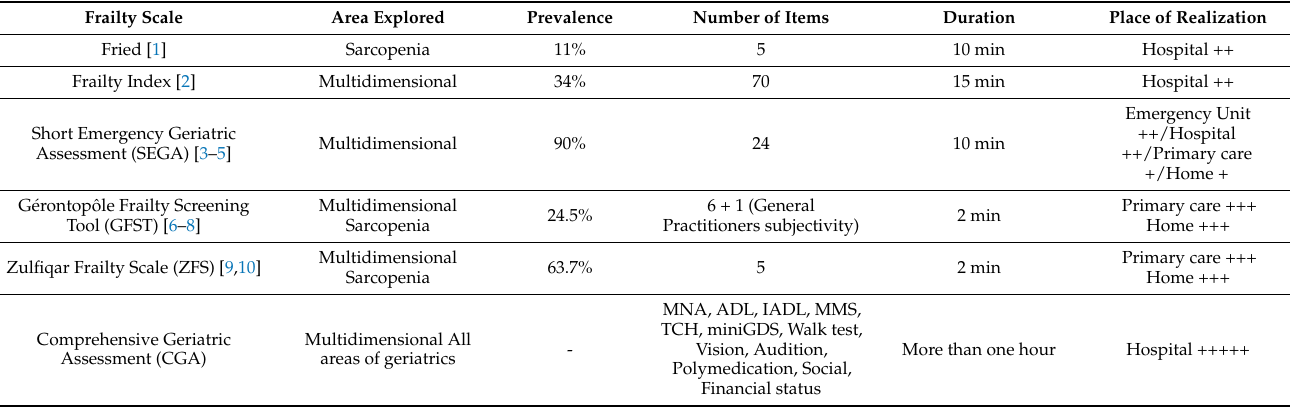
Table 1. Frailty scales (non-exhaustive list).